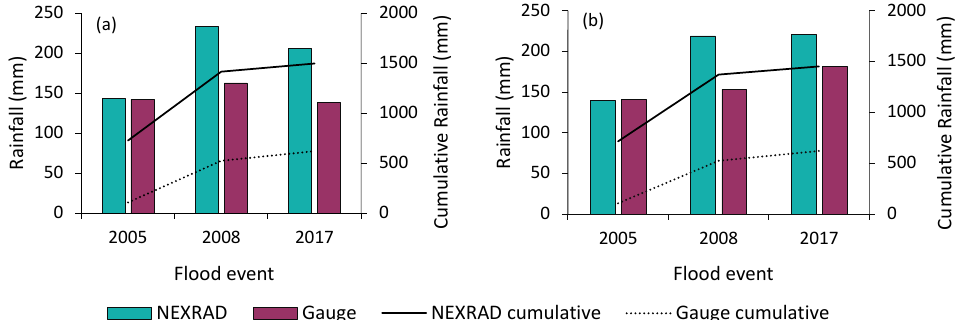
Figure 10. NEXRAD and gauge rainfall data of the flood events for two sub-watersheds ( a ) Upper Blue River and ( b ) Indiana Creek.